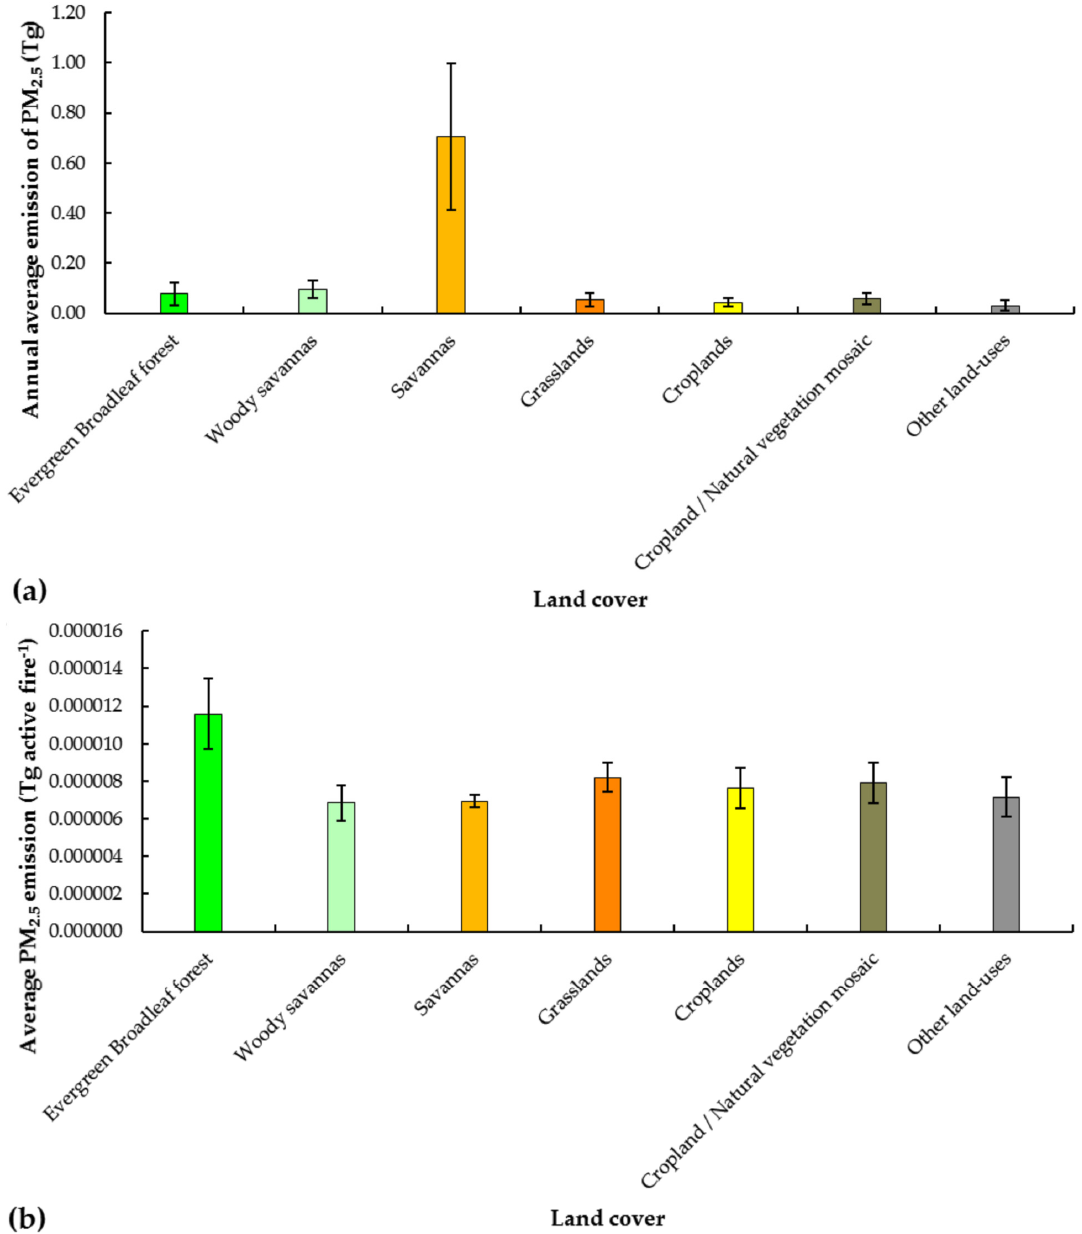
Figure 5. ( a ) Annual average emission of PM 2.5 associated with fires in the major land cover categories of the Cerrado biome and ( b ) Annual average emission of PM 2.5 associated with fires per active fire detected in the major land cover categories of the Cerrado. Estimates were obtained using PREP-CHEM-SRC 1.8.3 and considered the 2002–2017 period. Error bars represent the standard deviation. Active fires occurring in the evergreen broadleaf land cover emitted, on average, more PM 2.5 than active fires occurring in the savanna land cover (0.0000116 Tg per active fire and 0.0000069 Tg per active fire, respectively) or any other land cover of the Cerrado (Figure 5b). MODIS sensors